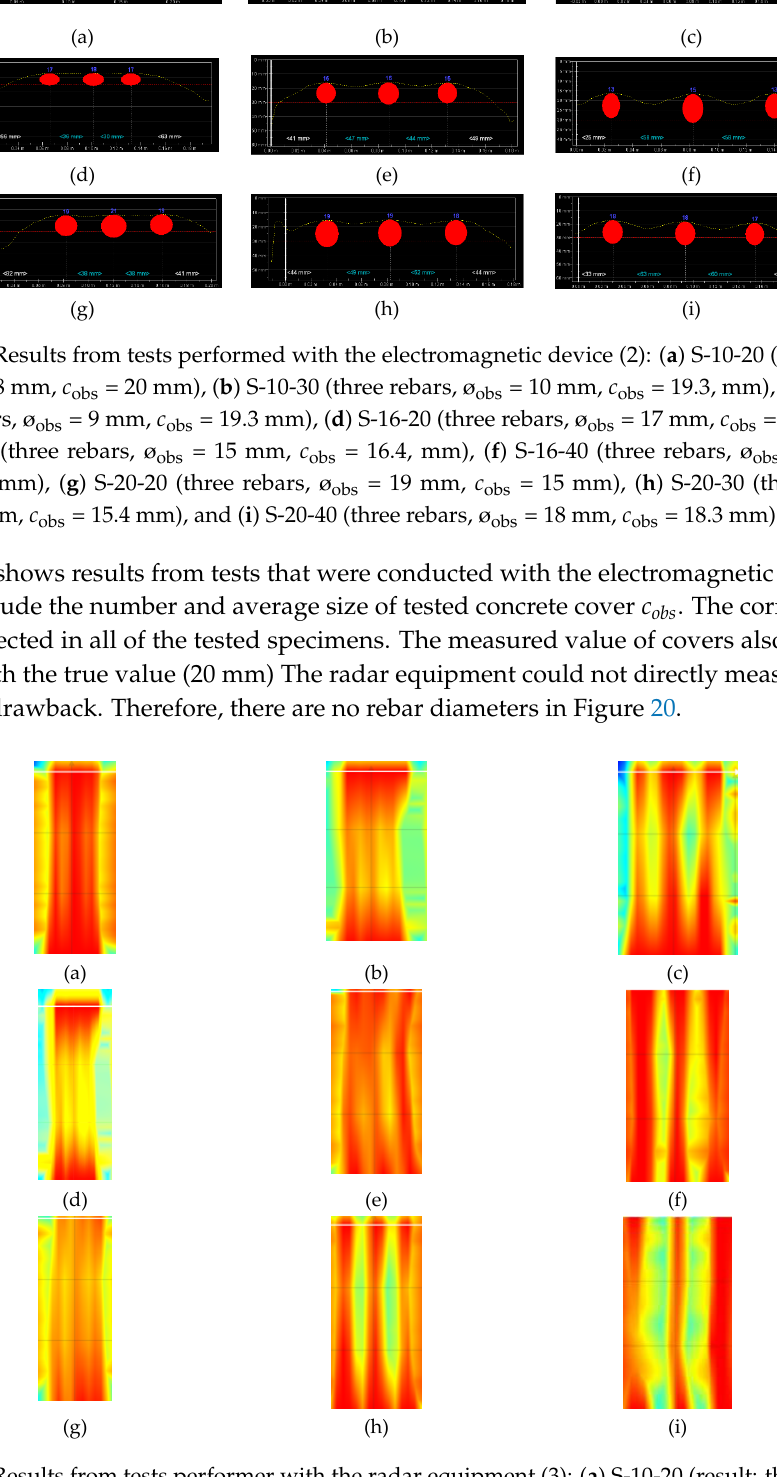
Figure 20. Results from tests performer with the radar equipment (3): ( a ) S-10-20 (result: three rebars, c obs = 22 mm), ( b ) S-10-30 (three rebars, c obs = 22 mm), ( c ) S-10-40 (three rebars, c obs = 21 mm), ( d ) S-16-20 (three rebars, c obs = 22 mm), ( e ) S-16-30 (three rebars, c obs = 21 mm), ( f ) S-16-40 (three rebars, c obs = 20 mm), ( g ) S-20-20 (three rebars, c obs = 22 mm), ( h ) S-20-30 (three rebars, c obs = 20 mm), ( i ) S-20-40 (three rebars, c obs = 20 mm)